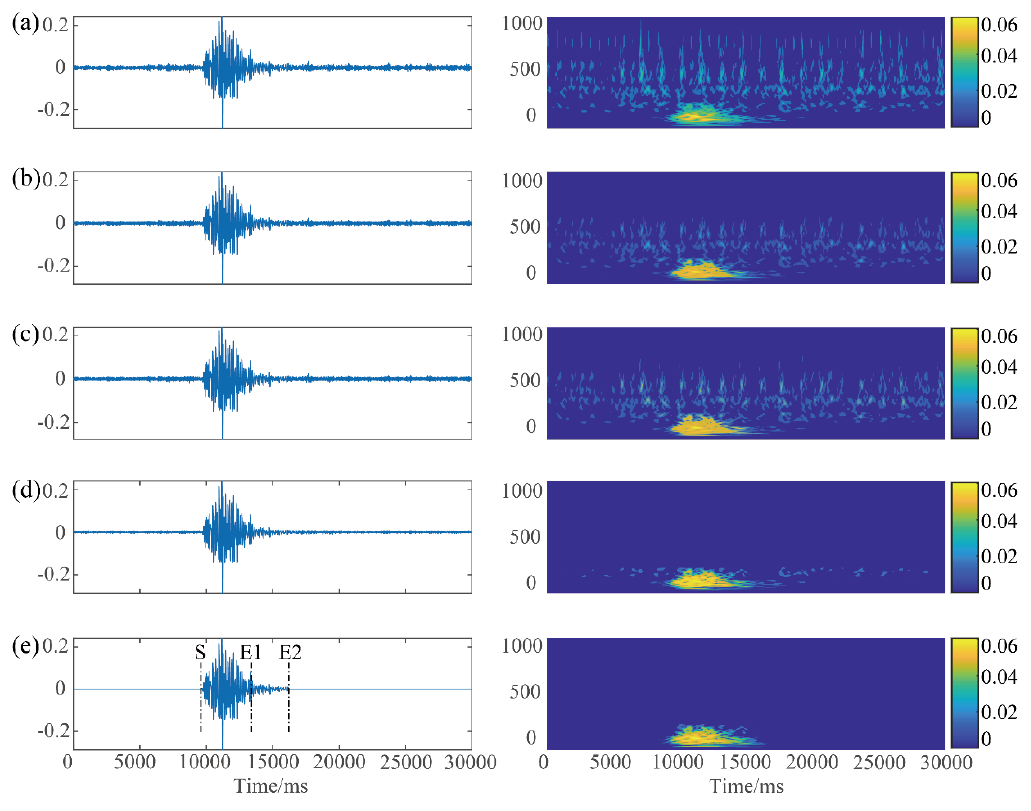
Figure 9. Waveforms and time-frequency diagrams of MS signal before and after noise reduction by EEMD, CEEMD, VMD and VMD-AIC. ( a ) Original noisy MS signal; ( b ) the signal denoised by EEMD; ( c ) the signal denoised by CEEMD; ( d ) the signal denoised by VMD; ( e ) the signal denoised by VMD-AIC. E1 means the end position of the first calculation, and E2 is the result of its second relocation.